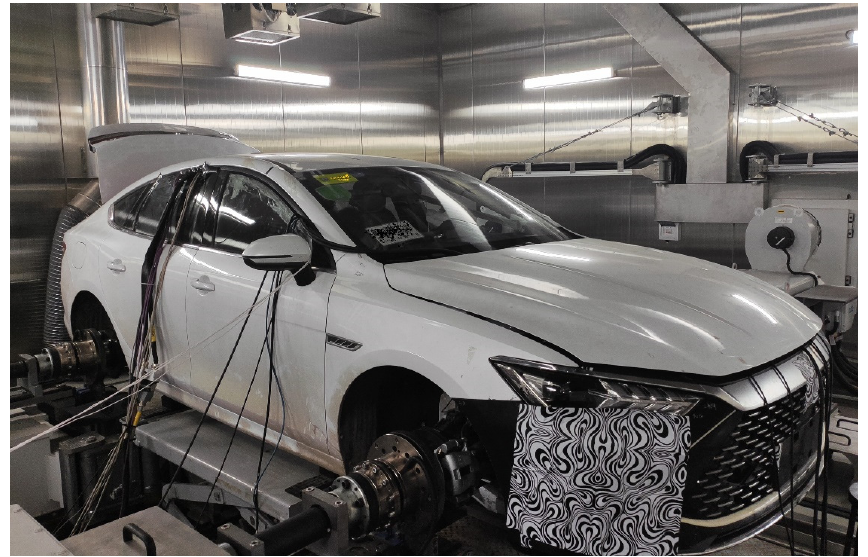
Figure 11. Picture of vehicle bench test.